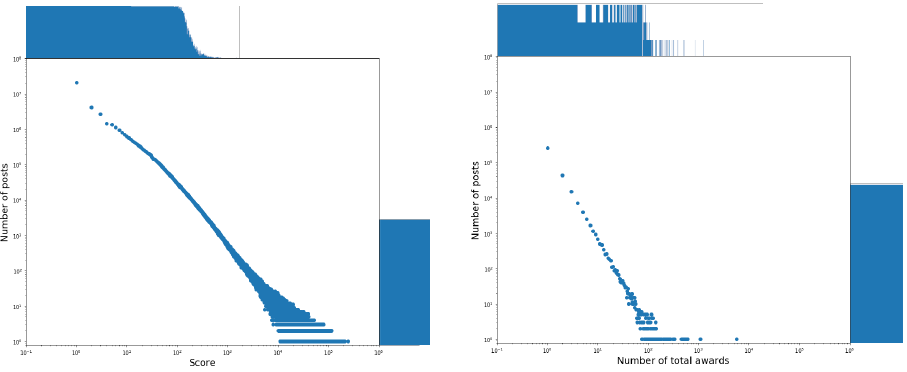
Figure 2. Distributions of posts against scores ( left , log–log scale) and awards ( right , log–log scale) enriched with marginal